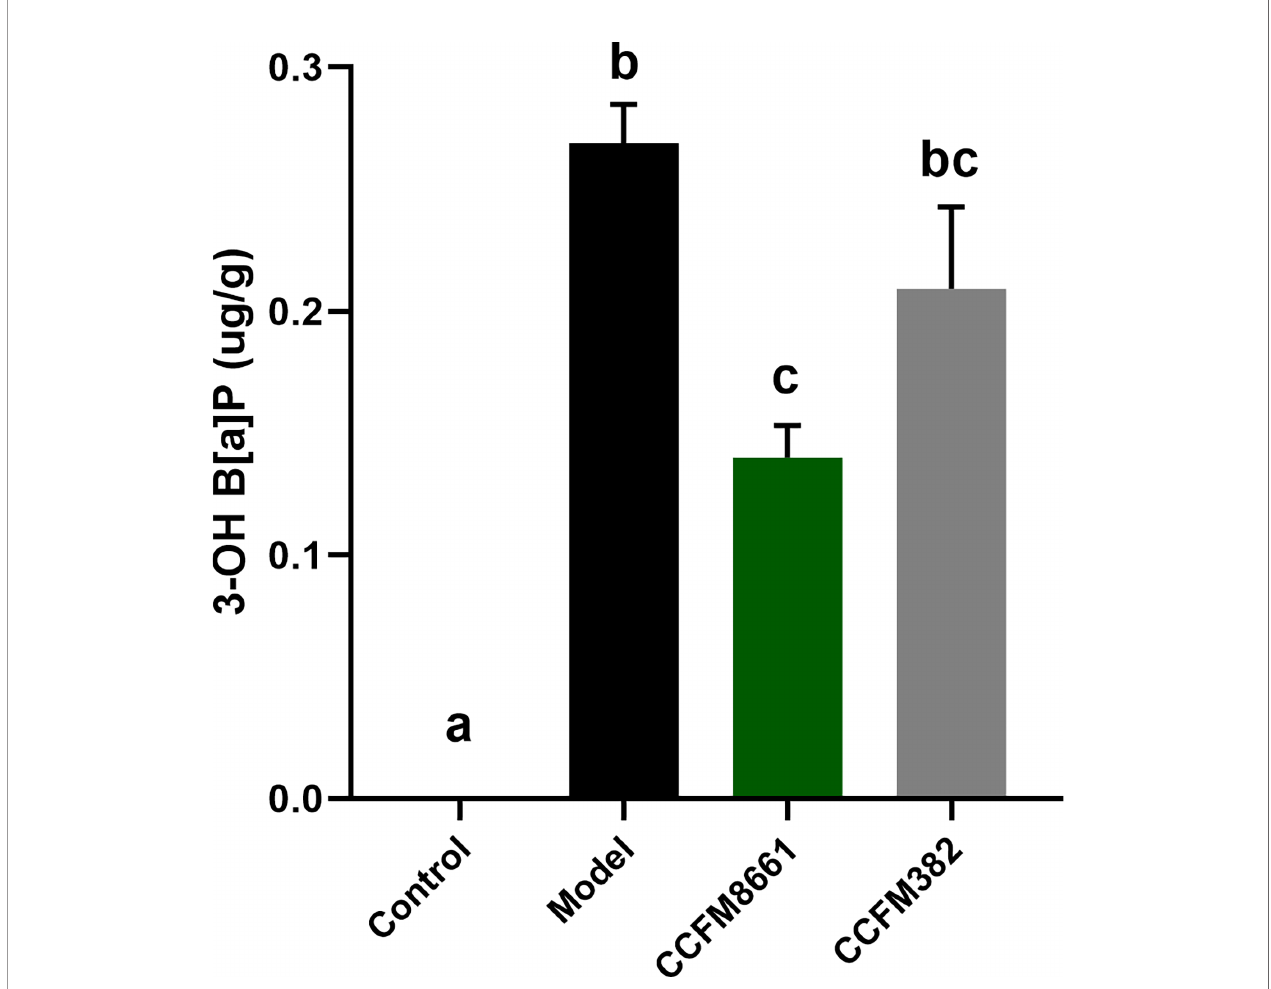
FIGURE 2 | Effect of L. plantarum CCFM8661 on 3-OH B[ a ]P levels in feces. The different letters indicate signi fi cant difference between groups ( P < 0.05 ).